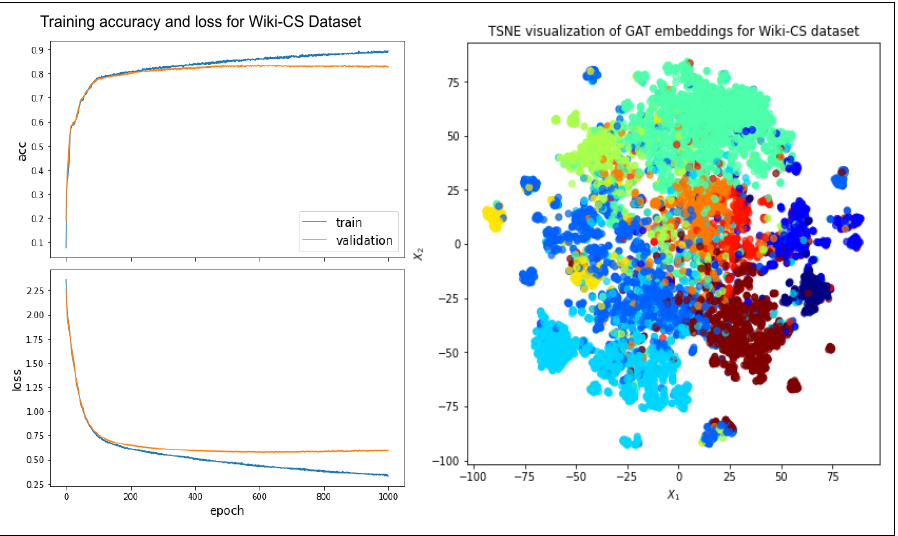
Figure 10. Graphical representation for Wiki-CS